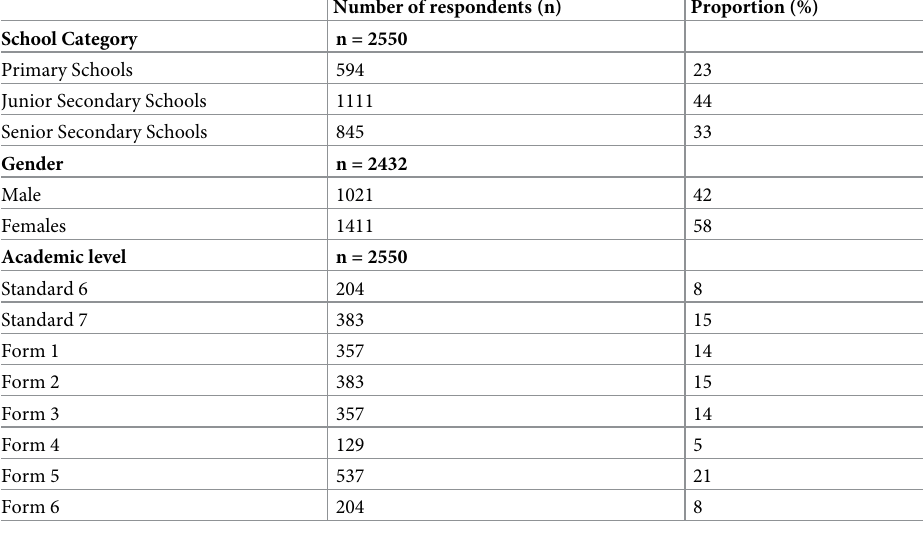
Table 1. Demographic characteristics of the study participants.